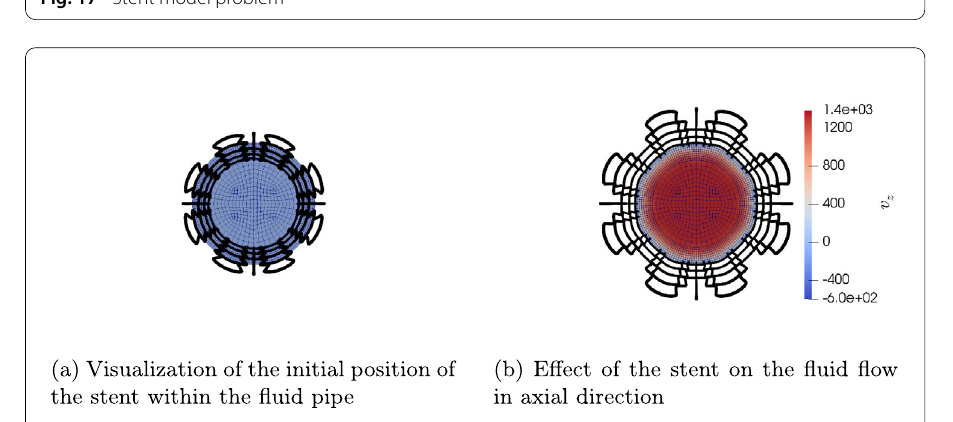
Fig. 18 Axial view of the fluid flow within the pipe in mm/s